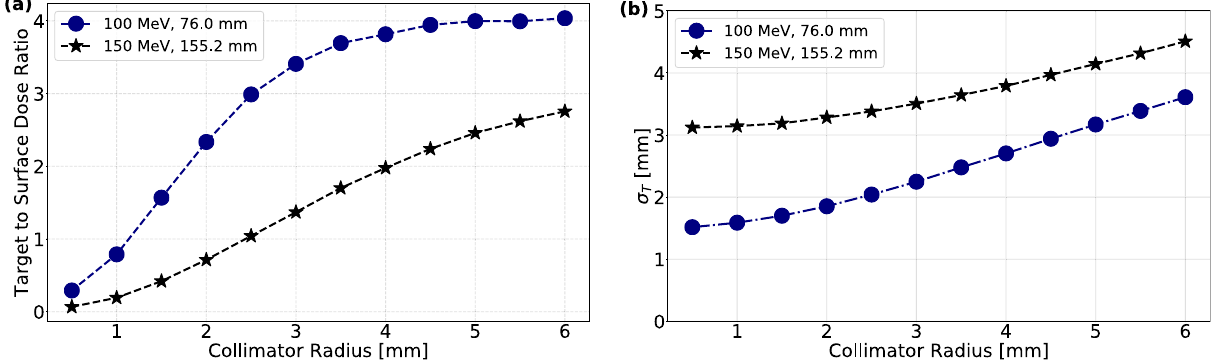
Figure 5. Comparison of 100 MeV and 150 MeV CECP beam: ( a ) TSDR and ( b ) σ t at the Bragg peak position as a function of collimator radius R .